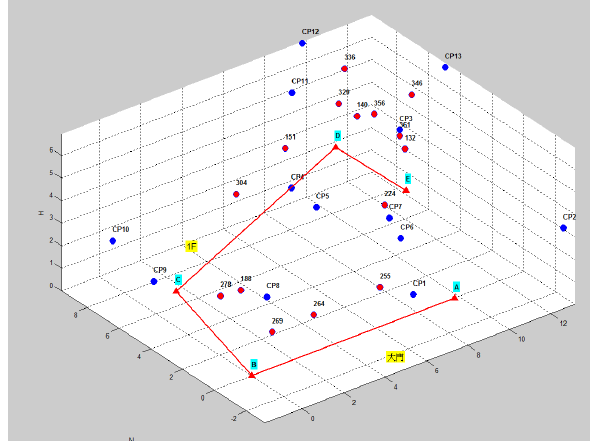
Figure 12. Distribution of the control SPIs.